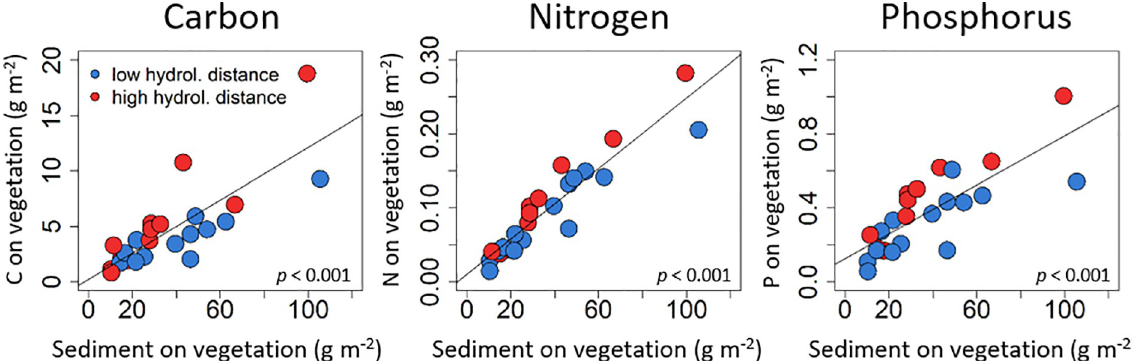
Fig 5. Nutrients on the vegetation. Carbon, nitrogen and phosphorus on the vegetation explained by the amount of sediment on the vegetation, and grouped by the mean for low and high hydrological distances from the river.